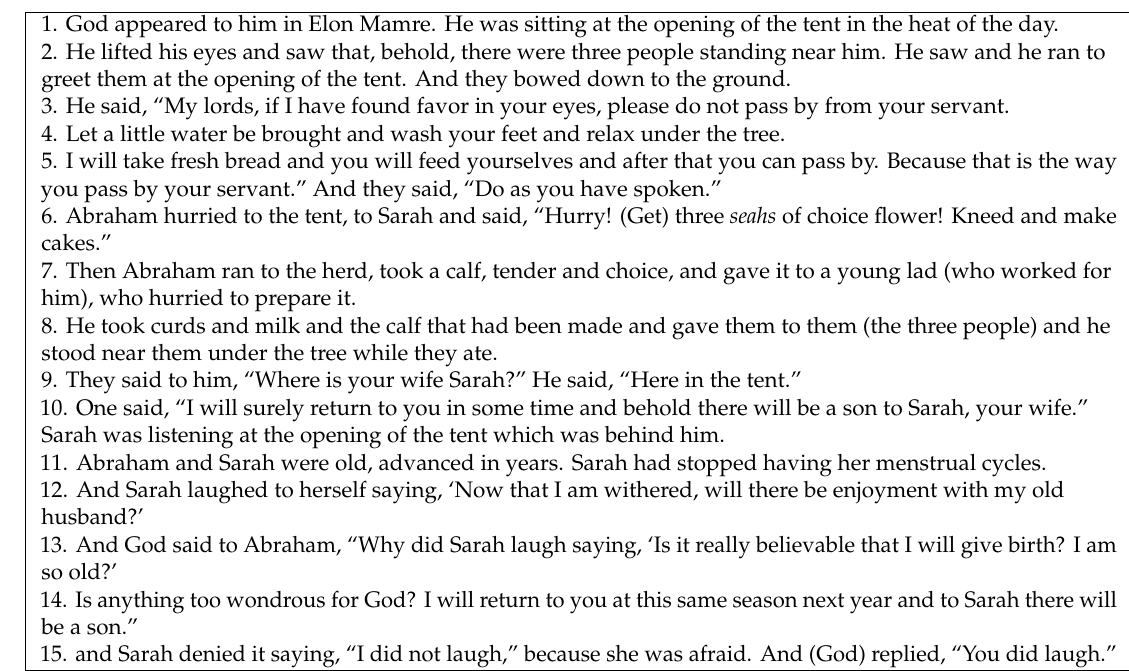
Table 1. Genesis 18:1–15: Abraham and Sarah are Promised a